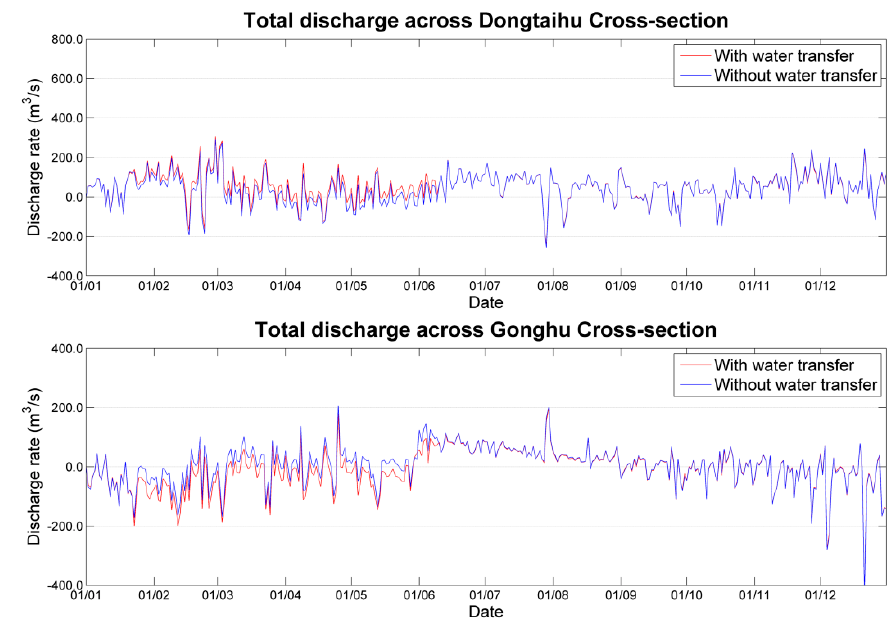
Figure 19. Total discharge of Gonghu Bay and Dongtaihu Bay. The red lines refer to the reference case, while blue line represents scenarios without water transfer.